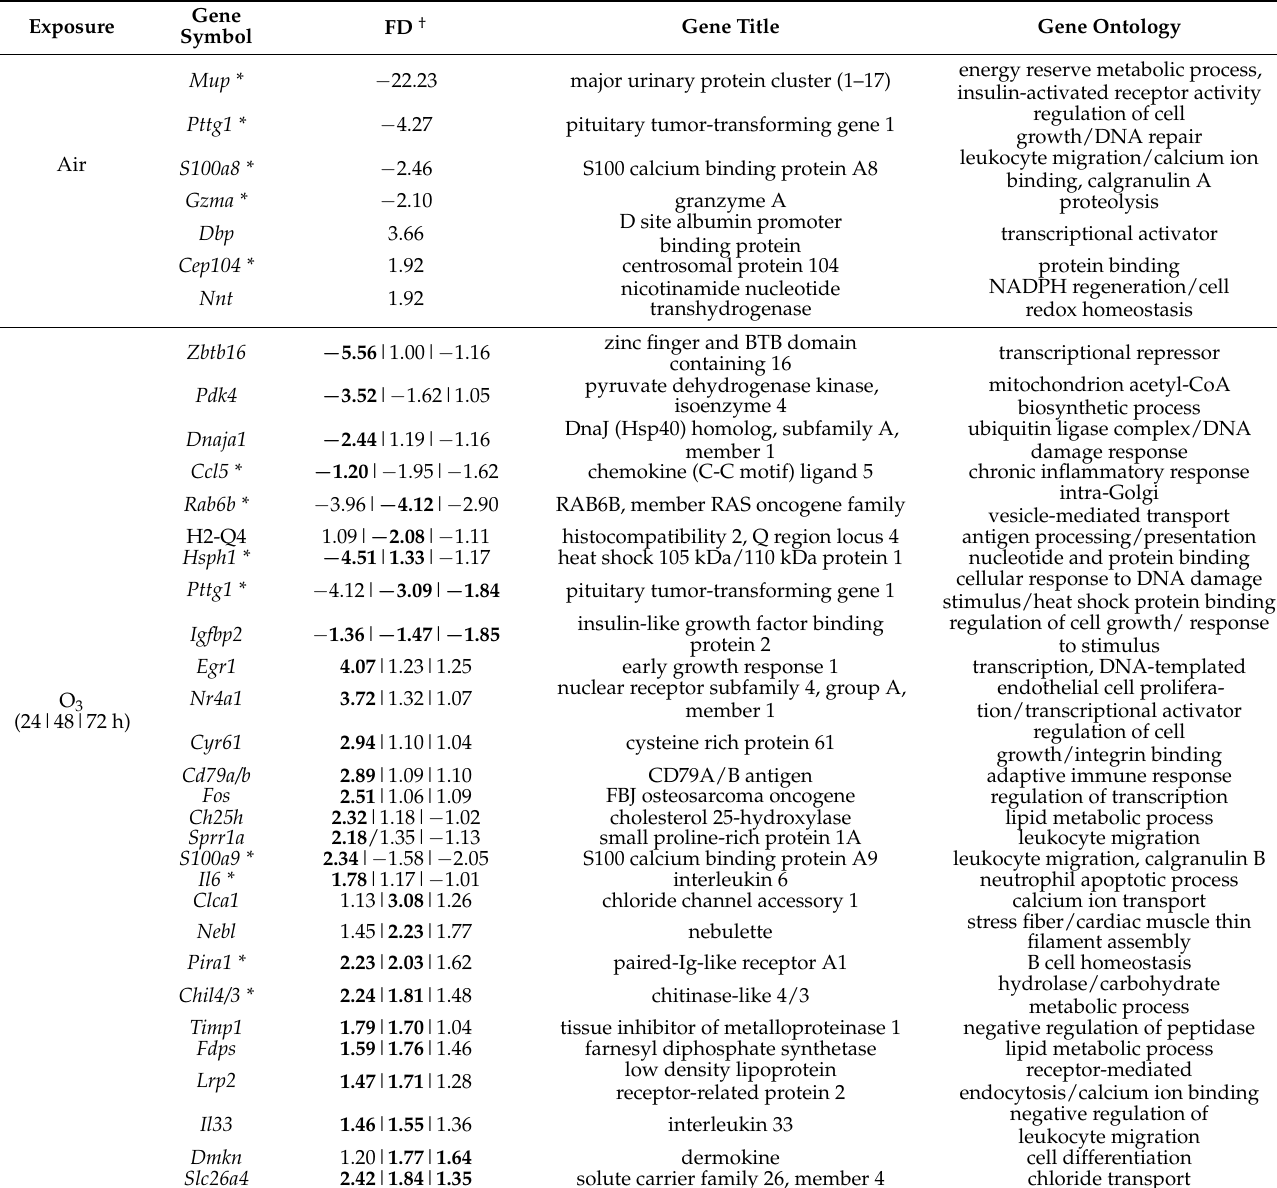
Table 2. Selected tumor necrosis factor receptor (TNFR)-dependent lung genes after air or ozone (O 3 ) exposure.